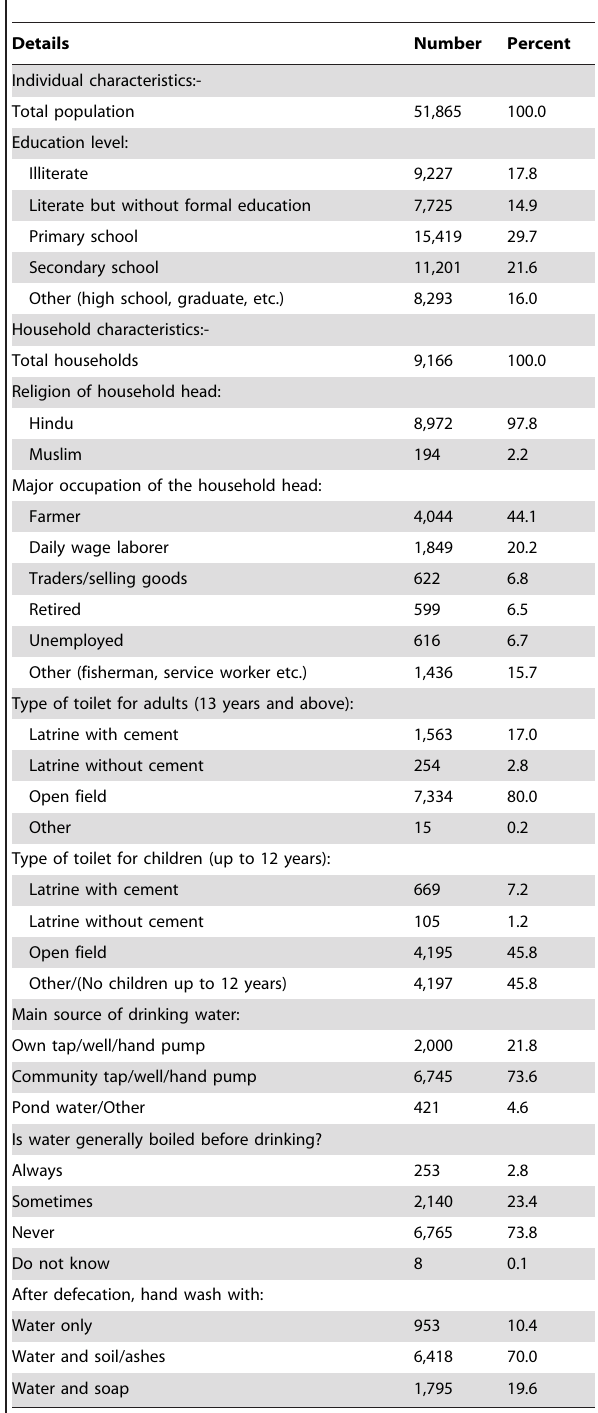
Table 1. Individual and household characteristics of the study population in Satyabadi block in Odisha,